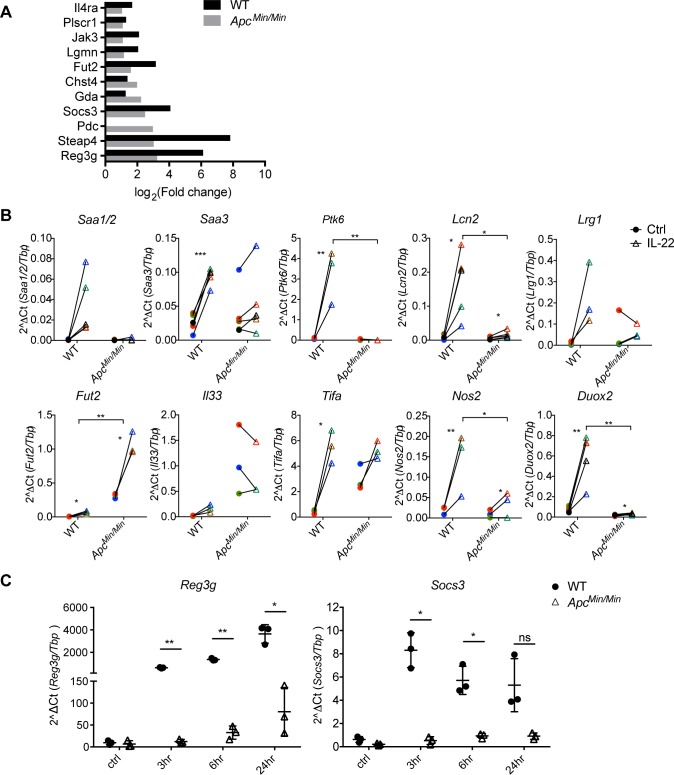
APC-mutant intestinal epithelial cells are defective in IL-22 mediated gene regulation.(A). WT and ApcMin/Min organoids were treated with IL-22 (2 ng/ml) for 3 hours. RNA was isolated for RNAseq analysis. Graph shows the fold change of genes induced by IL-22 in WT and ApcMin/Min organoids. The 11 genes shown were the only genes up-regulated by IL-22 in ApcMin/Min organoids (p < 0.1). (B) Expression of candidate up-regulated genes from RNAseq data were verified by RT-qPCR. Data shown are relative levels of mRNA for genes of interest relative to Tbp expression. At least 3 independent experiments were performed in each case. *p < 0.05, **p < 0.01, ***p < 0.001 on paired t test. (C). WT and ApcMin/Min organoids were treated with IL-22 (10 ng/ml) for 3, 6, or 24 hours, and RT-qPCR analysis was performed. Data show the relative expression of mRNA for Reg3g or Socs3 compared to Tbp. Three independent experiments were performed. *p < 0.05, **p < 0.01, paired t test. Numerical values for (A), (B), and (C) are available in S1 Data. APC, adenomatous polyposis coli; IL-22, interleukin-22; Reg3g, regenerated islet-derived protein 3 gamma; RNAseq, RNA sequencing; RT-qPCR, quantitative reverse transcription polymerase chain reaction; Socs3, Suppressor of cytokine signalling 3; Tbp, TATA box binding protein; WT, wild-type.